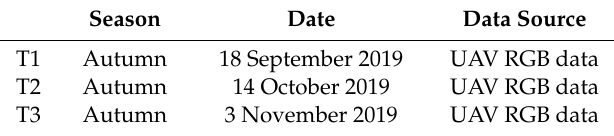
Table 2. Multi-temporal UAV images utilized in this study.